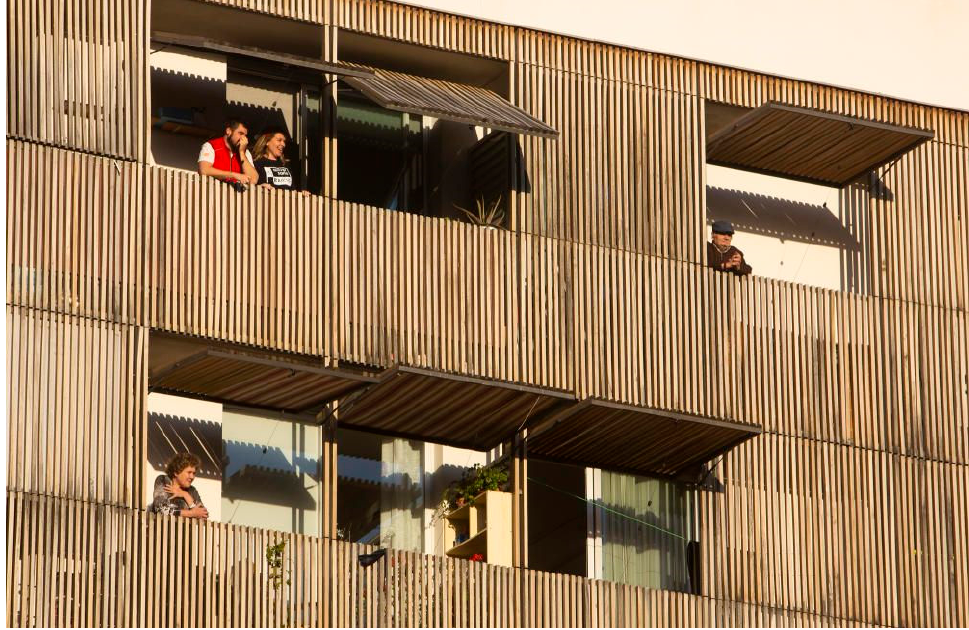
Figure 14. Detail of Plaza de América building’s main façade with some of its inhabitants, 2020. Courtesy of Rafa Arjones, Diario Información .